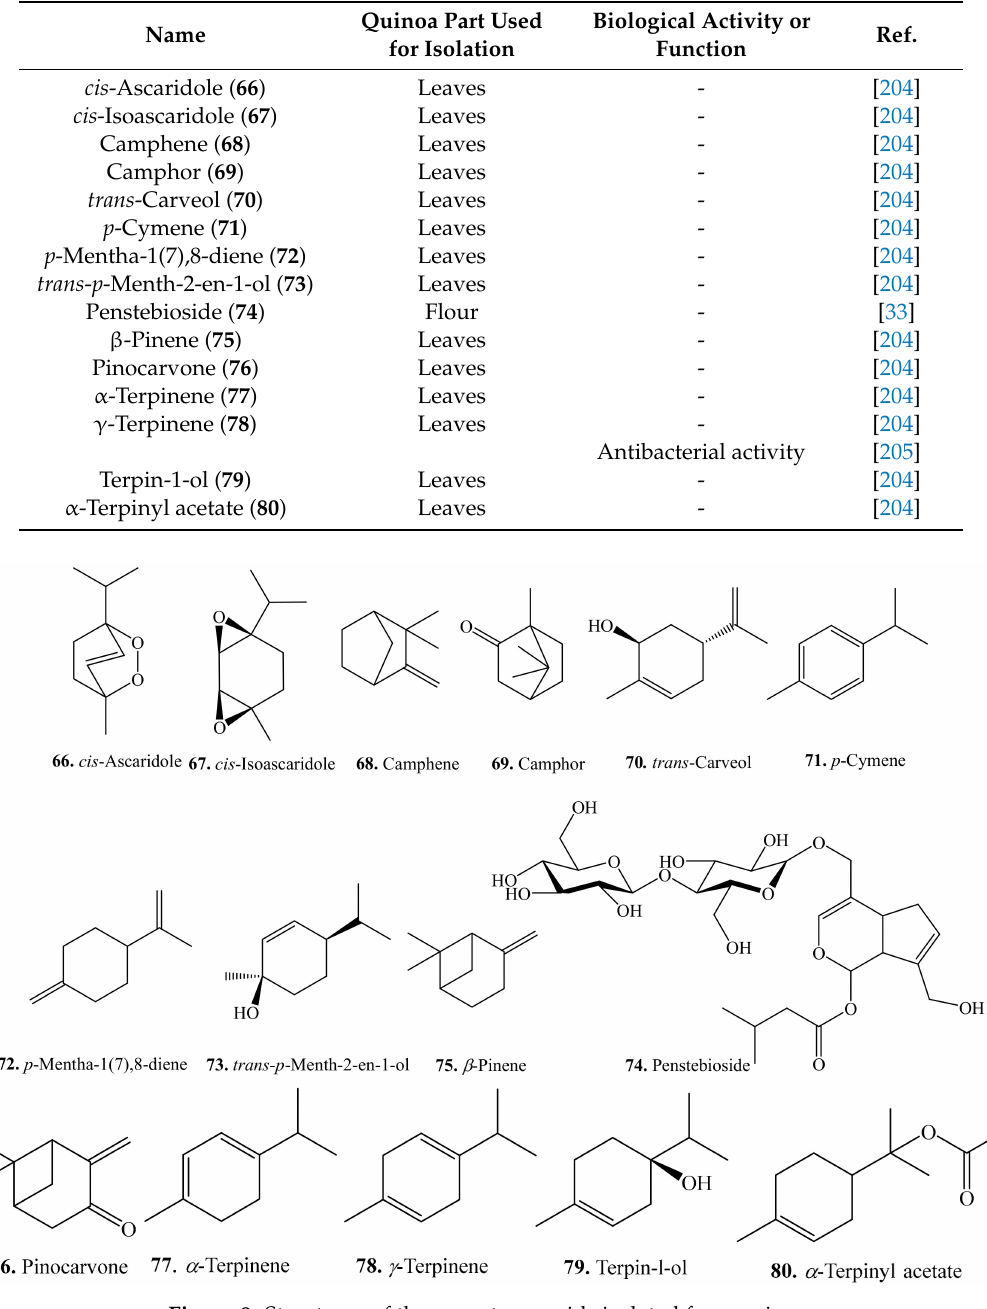
Table 8. Monoterpenoids and their biological activities or functions.